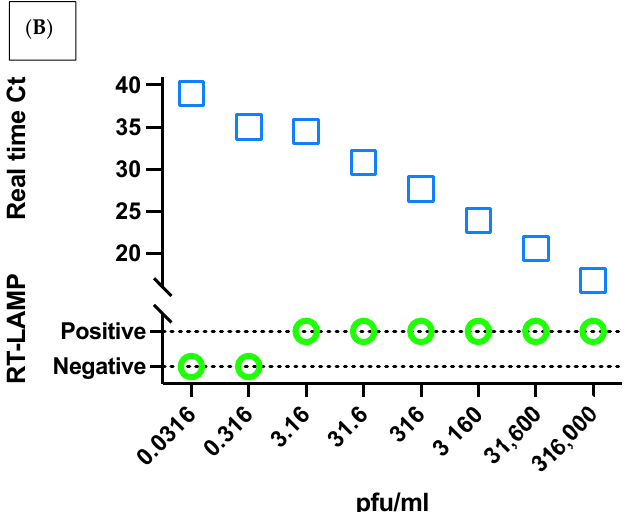
Figure 3. Comparison between RT-LAMP assay for MMix-A ( A ) and MMix-B ( B ) and the standard IVD approved SARS-CoV-2 diagnostic assay real-time RT-PCR. The lower part of the Y -axis represents the qualitative results of the RT-LAMP assay (positive/negative) while the upper part represents the corresponding Ct values when tested by real-time RT-PCR.